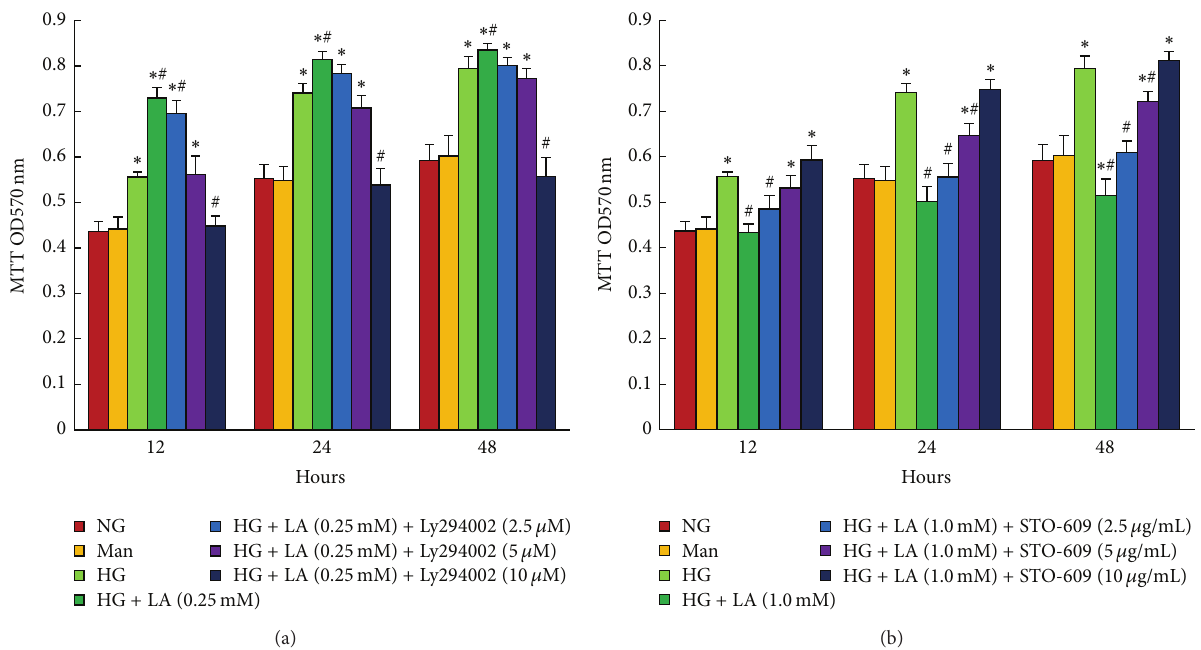
Figure 6: MTT assay for cell proliferation analysis. LY294002 dose-dependently inhibited mesangial cell proliferation induced by 0.25 mM LA. 10 𝜇 g/mL STO-609 completely abolished the inhibition of mesangial cell proliferation, which was caused by 1.0mM LA. Data in the bar graphs represent the mean ± SD ( 𝑛 = 6 ). 𝑃 < 0.05 was considered statistically significant. Note: ∗ 𝑃 < 0.05 versus NG; # 𝑃 < 0.05 versus HG. Abbreviations: NG, normal glucose (5mM); Man (5mM glucose + 25 mM mannitol); HG, high glucose (30